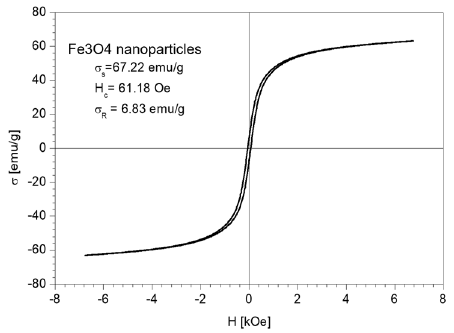
Figure 12. The hysteresis loop of Fe 3 O 4 nanoparticles sample.